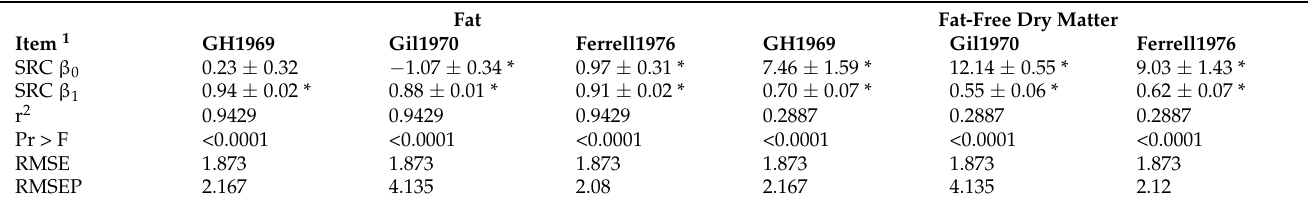
Table 5. Model evaluation of predicting empty body chemical fat and fat-free dry matter assuming empty body water is known, and predictive variables of the deviance between observed and predicted empty body chemical components in the Empty Body